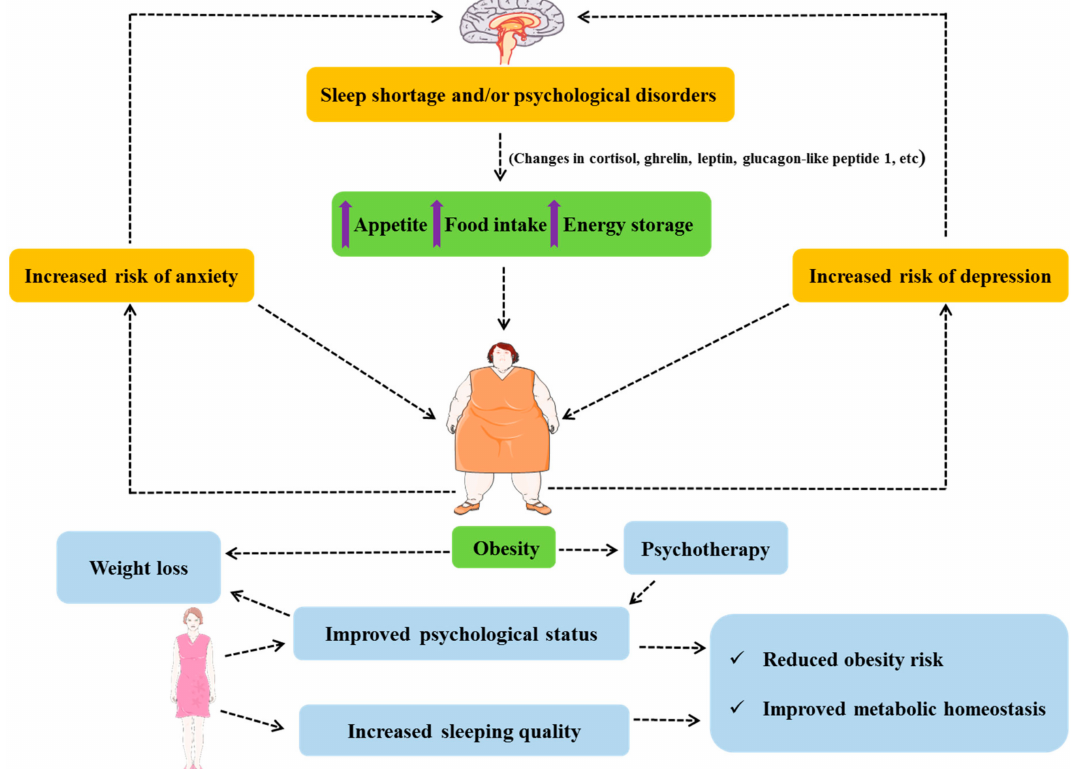
Figure 3. Sleeping, psychology and